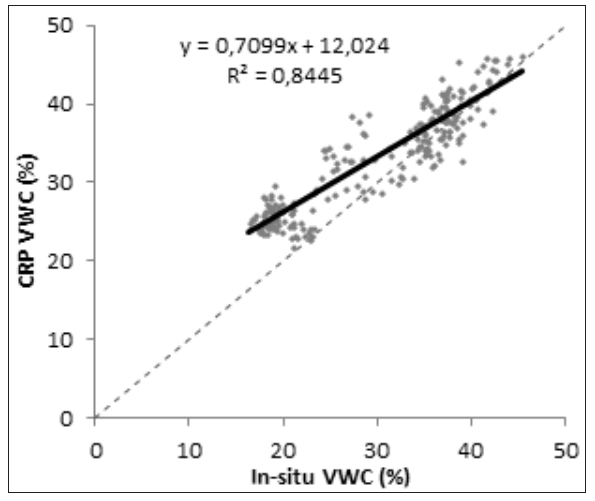
Figure 7: Scatterplot of in-situ versus cosmic ray probe (CRP) soil moisture estimates for the period 11 July 2014 to 1 March 2015. The dotted line indicates the 1:1 line. A paired t -test (Table 2) revealed that the mean of the CRP was 3.5% higher than the in-situ data (negative t -statistic). The variance for the in-situ soil moisture was higher than the CRP by 30 and suggests the higher variation of point measurements when compared to the large area average of the CRP. The absolute value of the t -statistic (4.827) was greater than the critical two-tail value (1.965) and the p -value (1.919x10 -6 ) was less than the alpha value (0.05) showing that there was a significant difference between the methods. The differences between the in-situ and the CRP soil moisture estimates can be explained by the following. The in-situ data set was not the actual average of the catchment, but the average of the sensors in the catchment. If the sensors were placed in different locations in the catchment, the in-situ data set could be different. The area covered by the in-situ sensors was smaller than that covered by the CRP. The in-situ soil moisture sensors were a maximum of 200 m away from the CRP; however, the CRP has a measurement footprint that exceeds 200 m in radius.